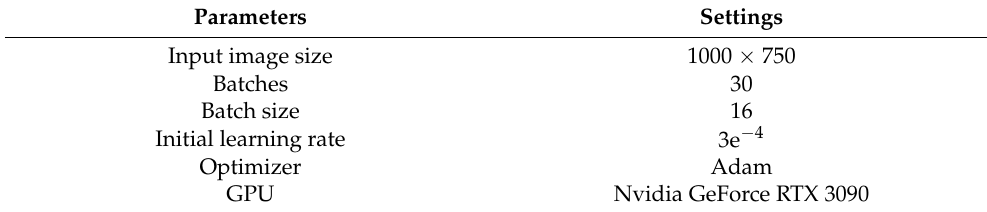
Table 3. Experimental settings for spherular pearlite